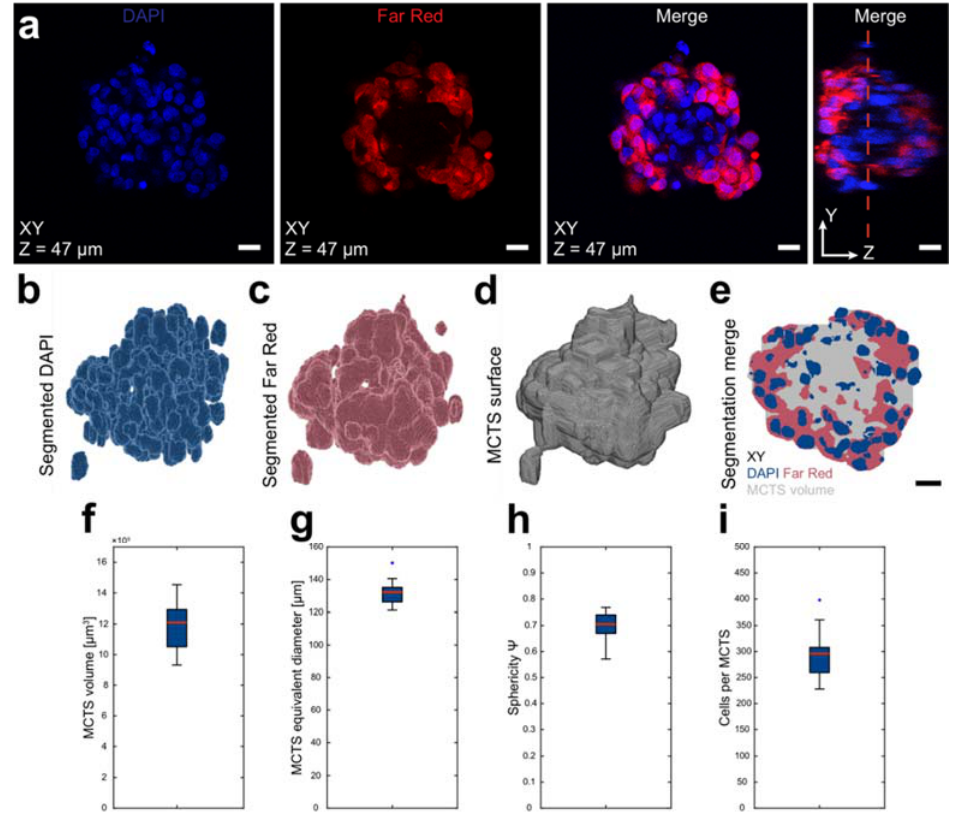
Figure 2. Raw data, segmentation strategy and core ‐ shell MCTS characteristics. After 48 h (24 + 24 h) of USW formation, the core ‐ shell MCTS were fixed, stained with DAPI (Invitrogen) and cleared. All cells were stained with DAPI while cells in the shell were identified by Far Red staining ( a ) . The red dotted line in the YZ plane indicates the XY optical section. Using a local adaptive thresholding algorithm, the DAPI ( b ) and Far Red ( c ) were segmented and used to approximate the MCTS surface and full volume ( d ). An XY ‐ section in the merged segmented volume is shown as reference ( e ). The MCTS surfaces from 20 MCTSs imaged by confocal microscopy were used to measure layered MCTS volume ( f ), which has an equivalent diameter of a sphere with the same volume as the MCTS ( g ) and sphericity Ψ ( h ). Using the median nucleus volume after a watershed algorithm in the segmented DAPI, the number of cells was estimated as total DAPI volume divided by the volume of a single nucleus ( i ). Boxplots show the 25th and 75th percentiles with a red line marking the median value. The whiskers show the furthest observation 1.5 times the interquartile length away from the box edge while outliers are marked with a blue dot. Scalebars are 20 µ